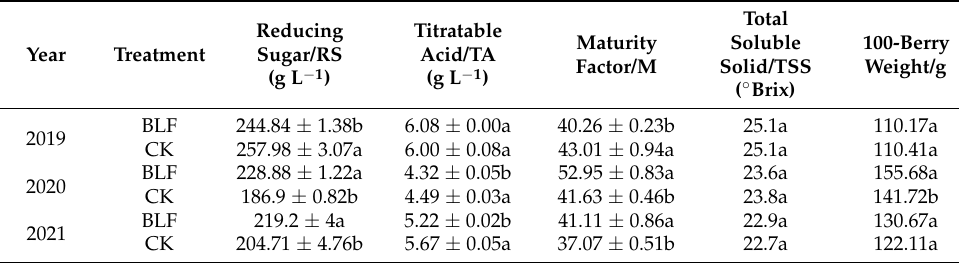
Table 1. General composition of ‘Cabernet sauvignon’ grapes from the two treatments (BLF, sprayed with biodegradable liquid film; CK, not treated) in 2019, 2020, and 2021.